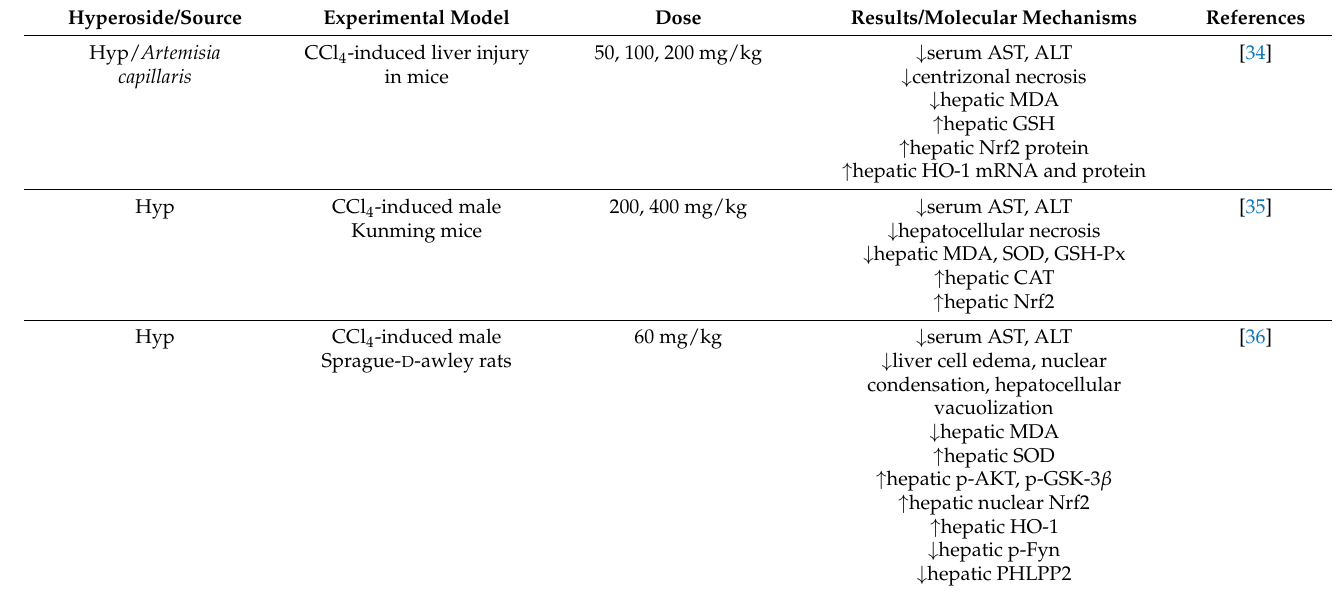
Table 1. Hepatoprotective activities of hyperoside (Hyp) in experimental models related to various liver